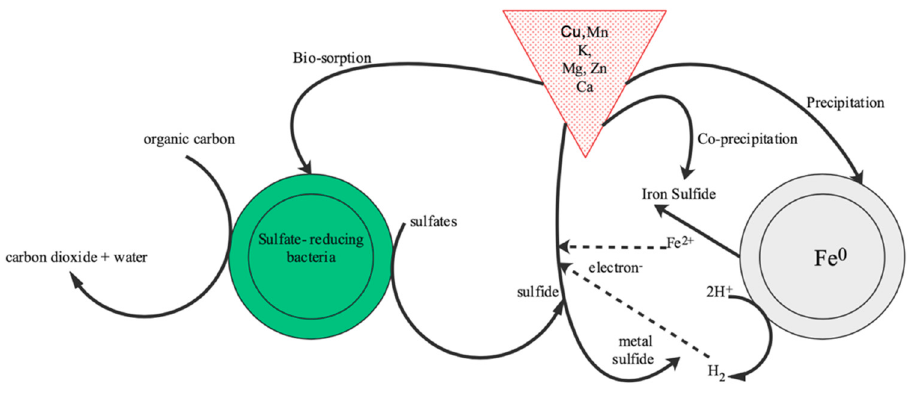
Figure 4. The elimination pathways of heavy metals in the (HWW+AMD)–nZVI system .